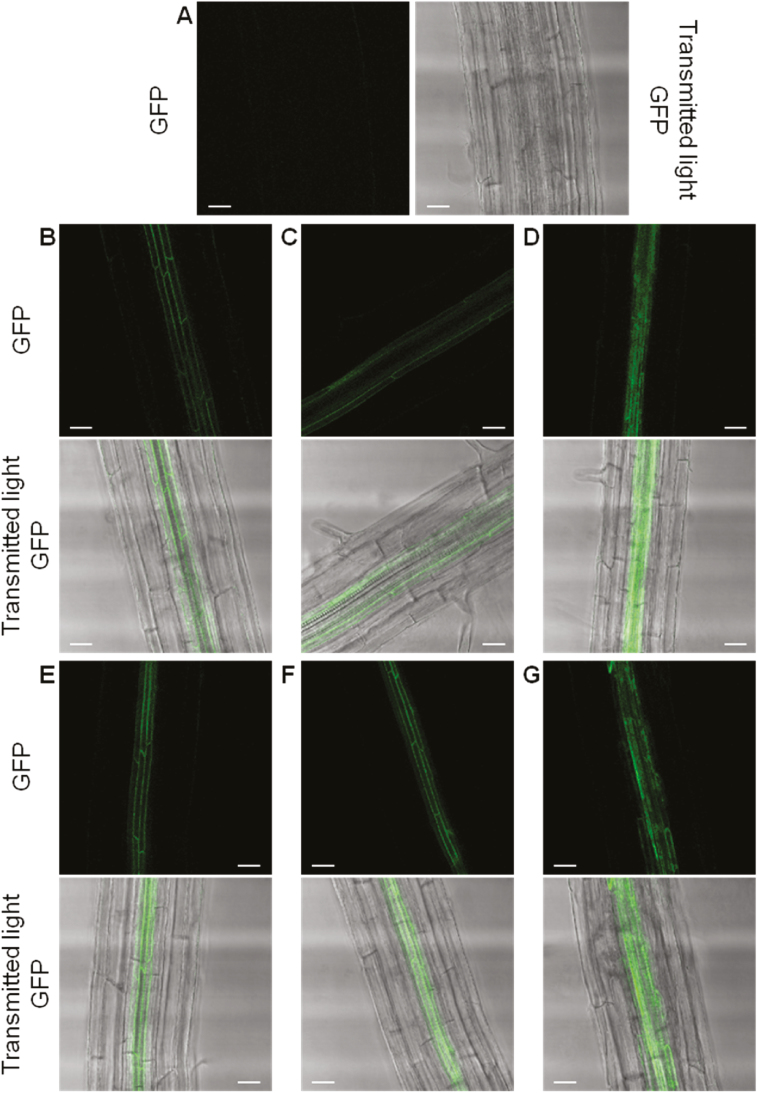
HMA4 variant localization in A. thaliana. The AtHMA4CCAA (B), AtHMA4CHA (C), AtHMA4Ctrunc (D), AhHMA4CCAA (E), AhHMA4CHA (F), and AhHMA4Ctrunc (G) variants fused to GFP and expressed under control of the copy 2 AhHMA4 promoter in Col-0 were imaged by confocal microscopy in roots of 18-day-old T1 seedlings. Non-transformed Col-0 seedlings (A) were used as negative controls. The images are, for each genotype, representative of three to six independent lines. Scale bars 25 µm. Ah, A. halleri; At, A. thaliana; CCAA: di-Cys→di-Ala motifs; CHA: HA: His- → Ala-stretch; CCAA: di-Cys → di-Ala motifs; CHA: HA and CCAA mutations combined; Ctrunc: fully truncated C-terminal extension.